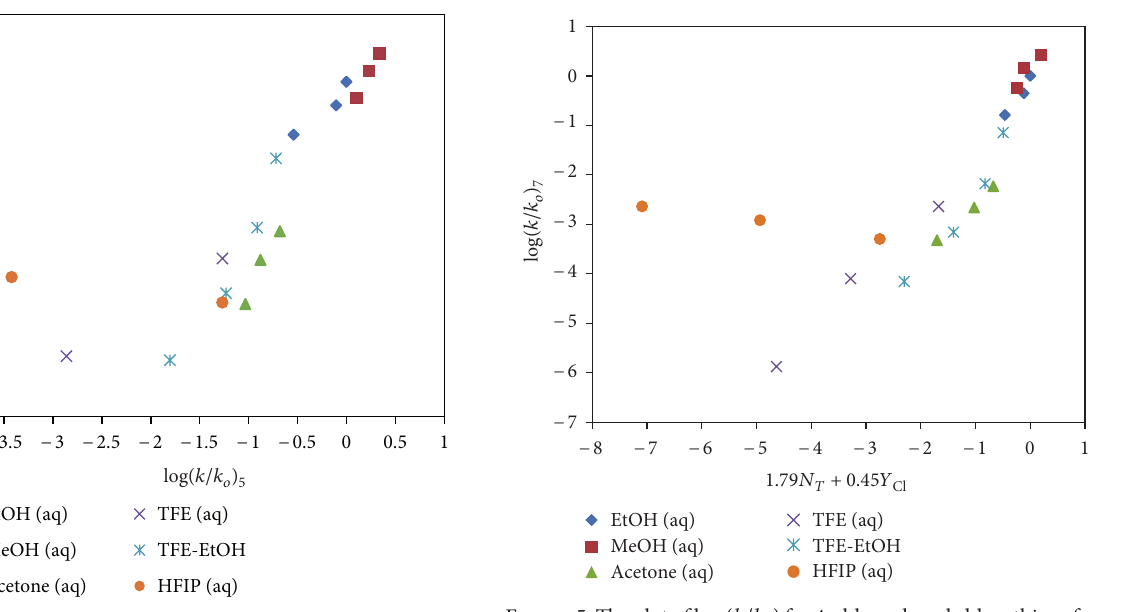
for 4-chlorophenyl chlorothiono- for phenyl �uorothionoformate ( 5 ) in (𝑘𝑘𝑘𝑘𝑘 𝑜𝑜 ) (𝑘𝑘𝑘𝑘𝑘 𝑜𝑜 )